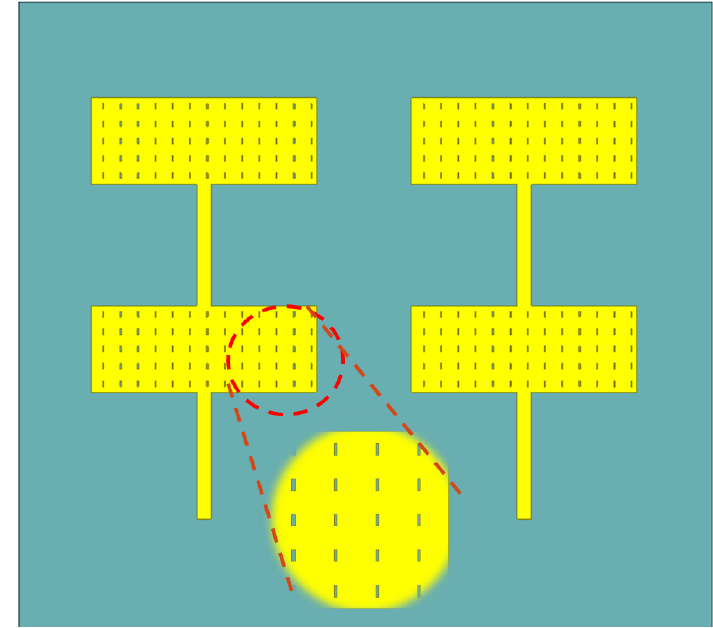
Figure 8. Add a rectangular slot to the antenna body.